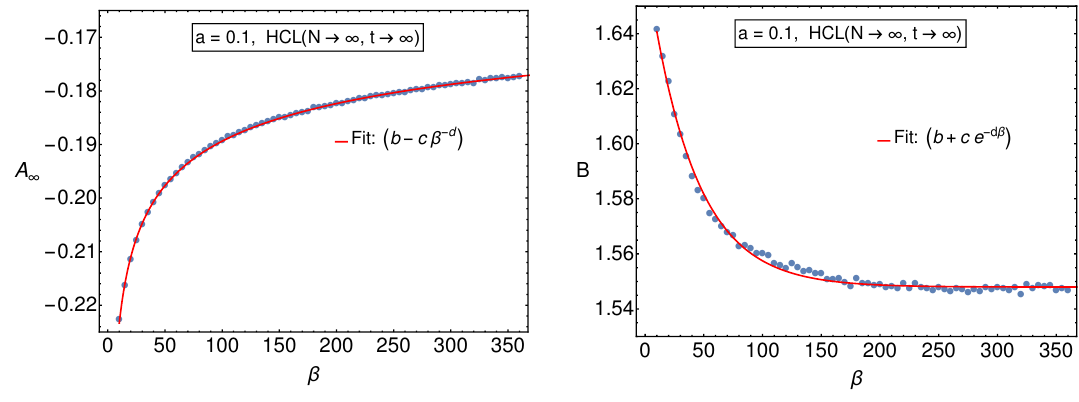
Figure 4 . Fit values A HCL (left) and B HCL (right) of the fit function (3.5) to the classical potential ∞ Im[ V (2) ( r )] /g 2 T computed within HCL for a wide parameter range β = 10 → 360 for a = 0 . 1 . Fits cl to the dependence of these parameters on β are shown as red curves, with the chosen form of the fit functions indicated in the label. The asymptotic values are A HCL B HCL ( β →∞ ) = 1 . 55